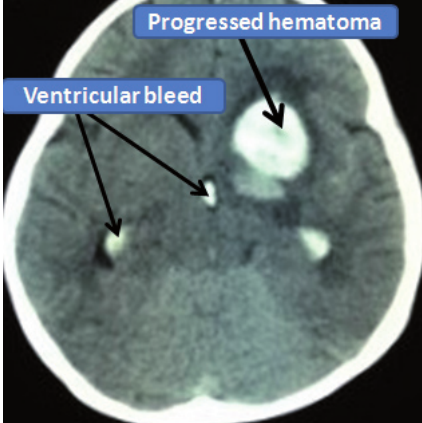
Figure 2. CT head showing evidence of re-bleed in the previous territory along with ventricular extension.